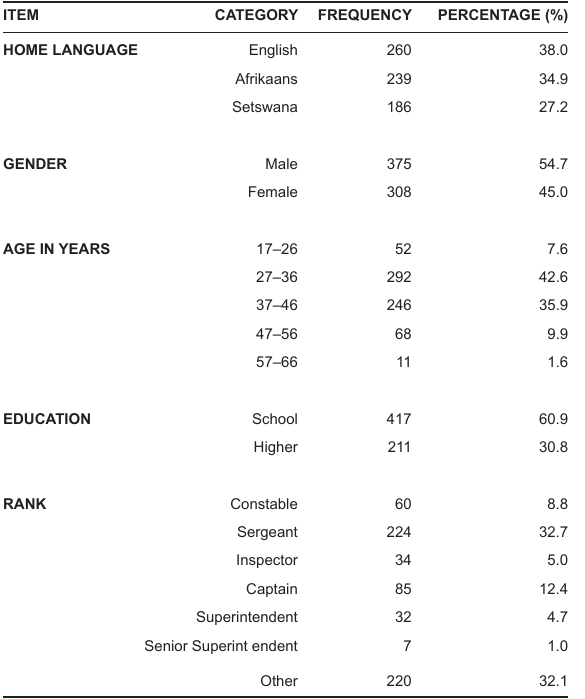
TABLE 1 Characteristics of the